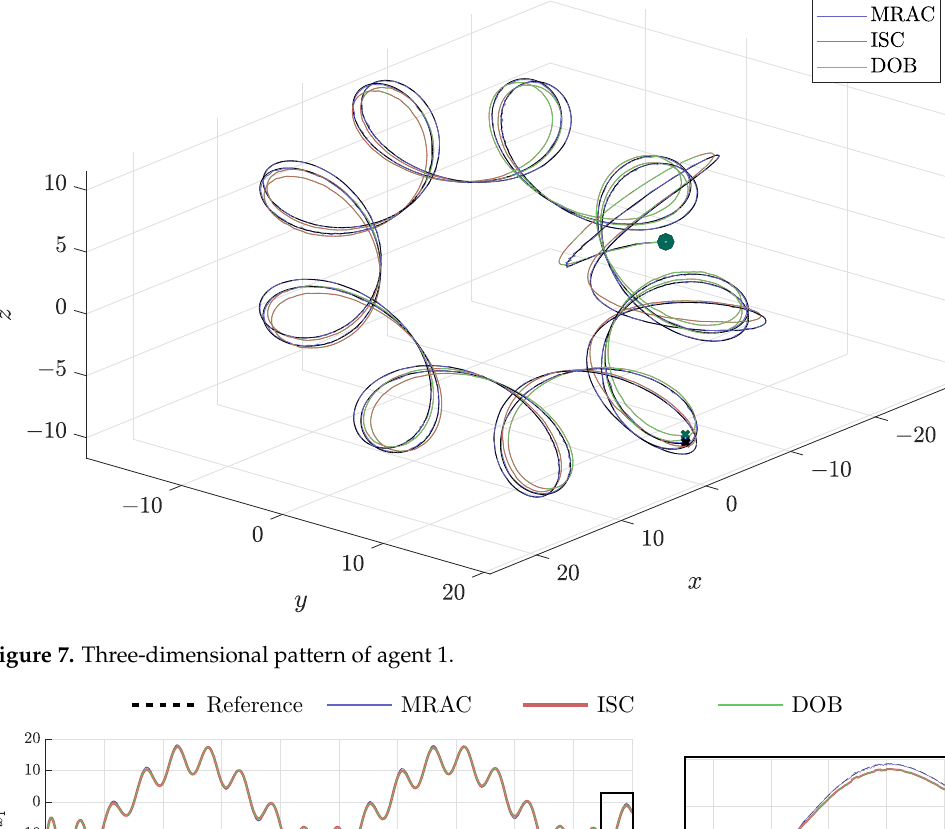
Figure 7. Three-dimensional pattern of agent 1.